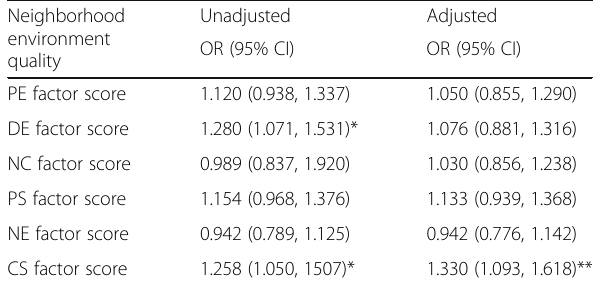
Table 4 Association between perceived neighborhood environment and self-reported general health ( n = 719) Neighborhood